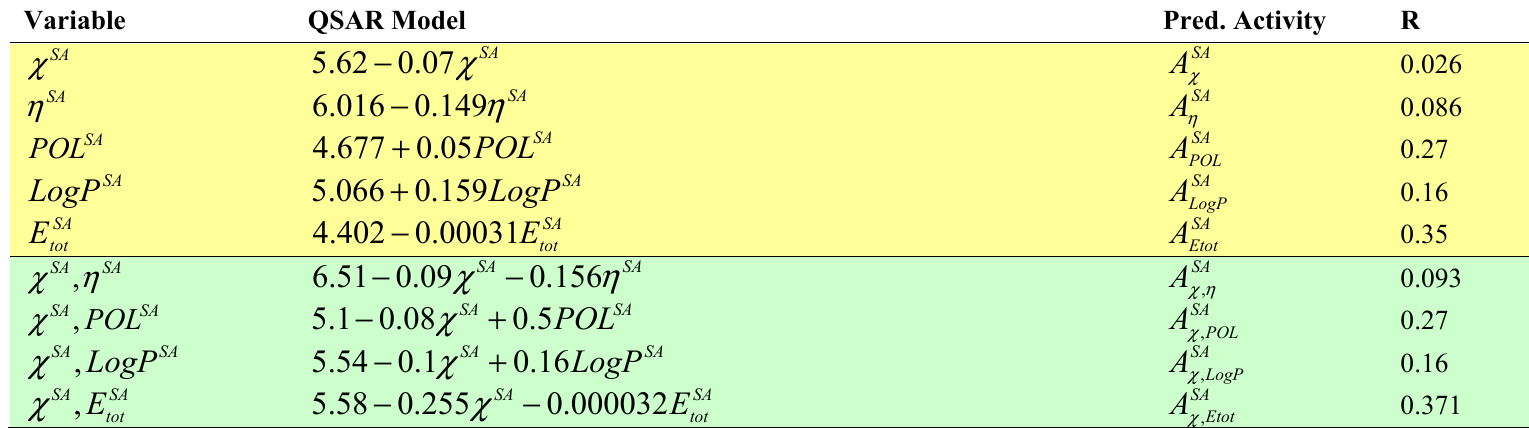
Table 3. QSAR models for the activities of the trial molecules with the physicochemical parameters of the SAs in Table